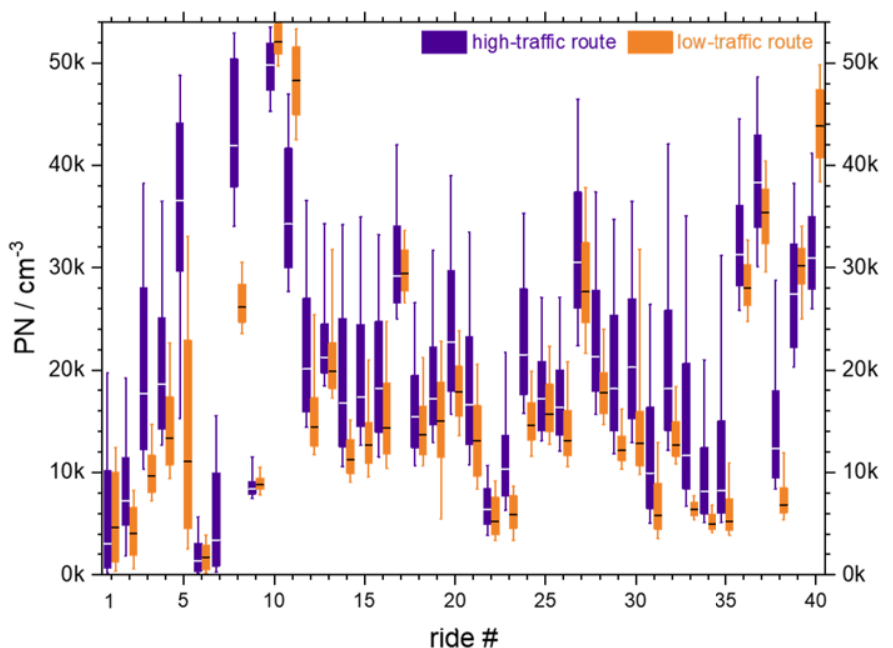
Figure 5. Box–whisker representations of PN concentrations on the high-traffic route (purple elements) and low-traffic route (orange elements) during all 40 rides. Boxes show interquartile ranges; whiskers show the 10–90% ranges. Medians are shown as white bars (on purple background) or black bars (on orange background). No data are available for ride 7, low-traffic route, due to instrument failure. Ride 3 is presented in detail in Figures 3 and 4.